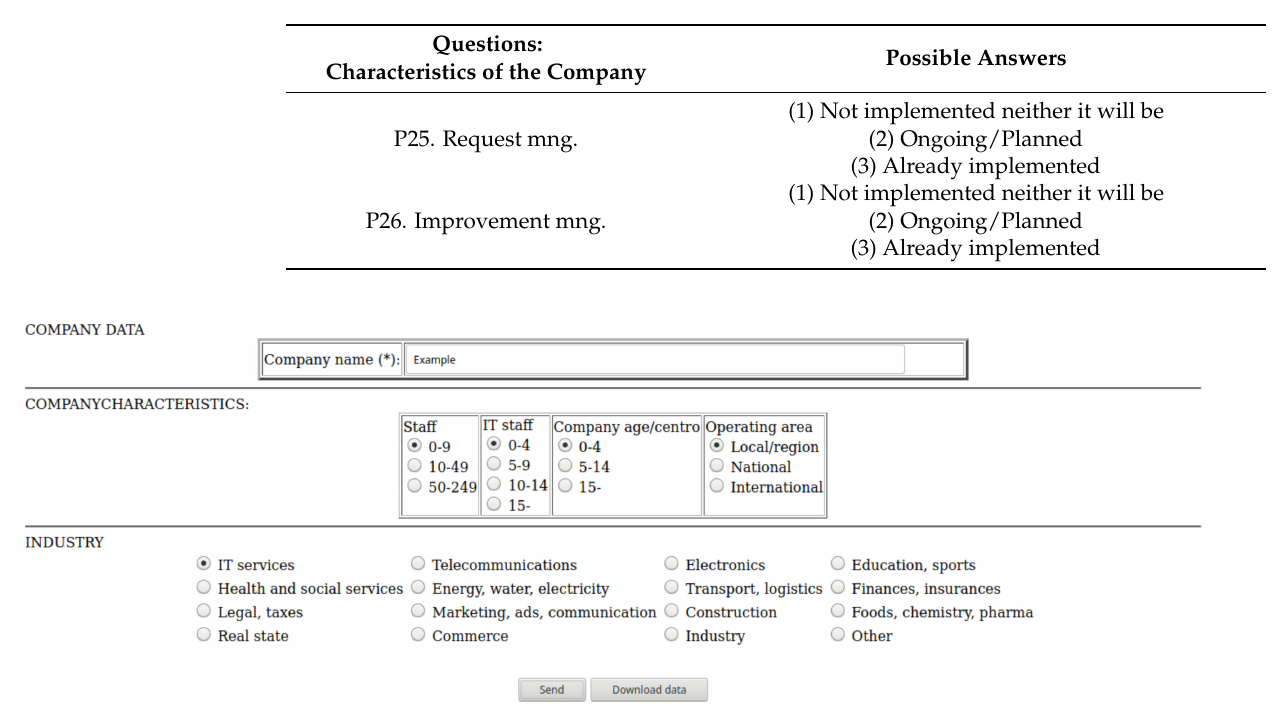
Figure A1. Web page in [https://doi.org/10.5281/zenodo.4587237] (accessed on 31 January 2021) to introduce data of company sequencing ITIL.